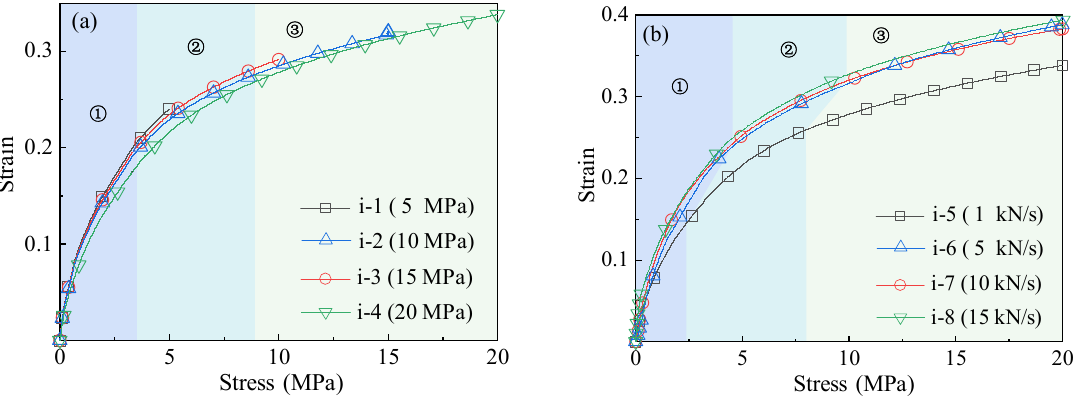
Figure 4. Stress–strain curves of the specimens during the test: ( a ) is the stress–strain curve for specimens i-1 to i-4; ( b ) is the stress–strain curve for specimens i-5 to i-8.